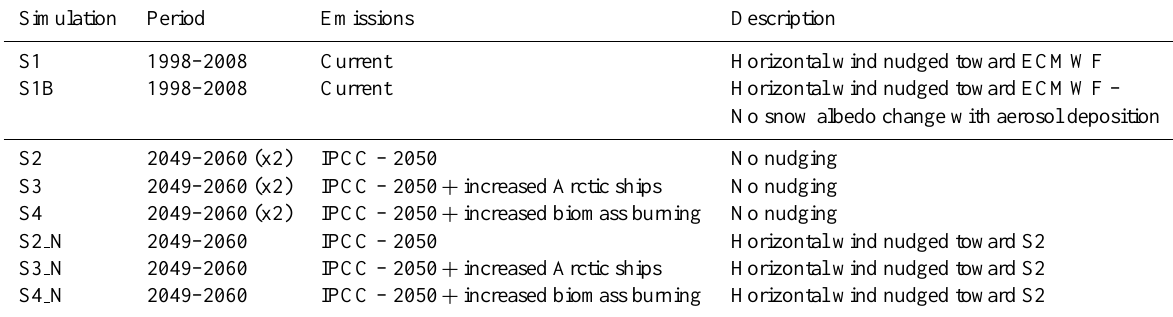
Table 1. Period, aerosol emissions and description of the nudging protocol for our 8 simulations. (x2) in the period means that the simulation was performed a second time with a slightly modified initial conditions to get 20yr of simulation as 10yr would clearly be insufficient to make comparisons statistically robust. Note that all simulations were made with prescribed sea surface temperature (SST, observed for present-day simulations, or simulated from a previous coupled ocean–atmosphere model simulation for future